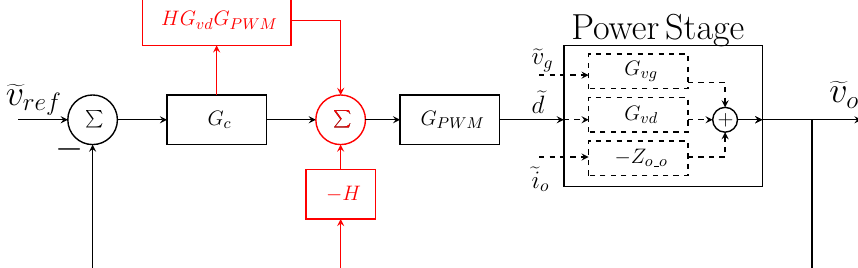
Figure 3. Closed-loop LRC using the proposed modifications in [30,31], where their additions to the original control are highlighted in